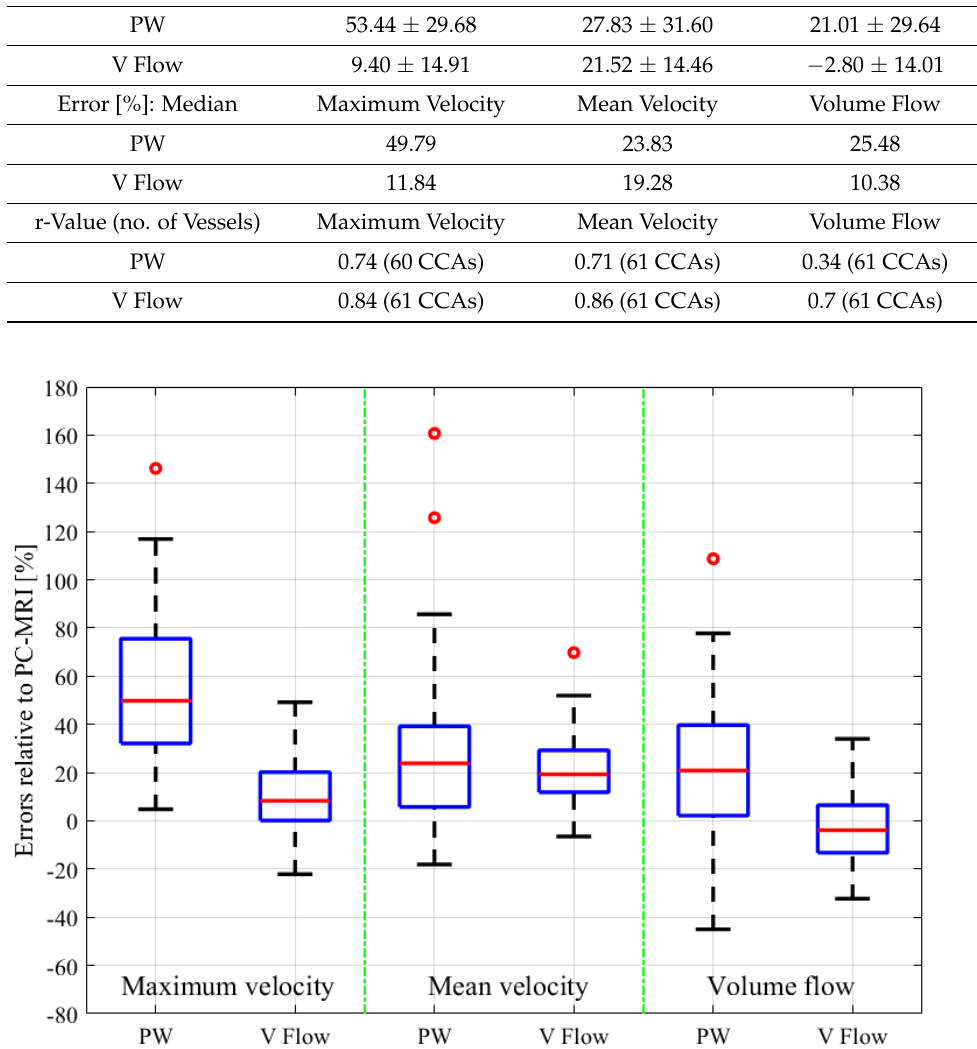
Figure 4. Boxplot for the relative errors of PW and V Flow compared to PC-MRI for maximum velocity, mean velocity and volume flow measurements.